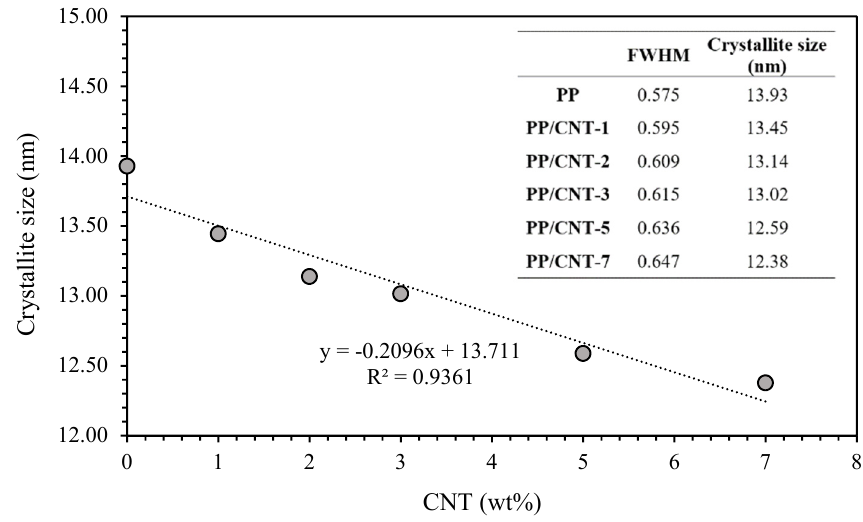
Figure 3: Crystallite size determined using Scherrer’s equation for the lattice plane (110) at 14.1°